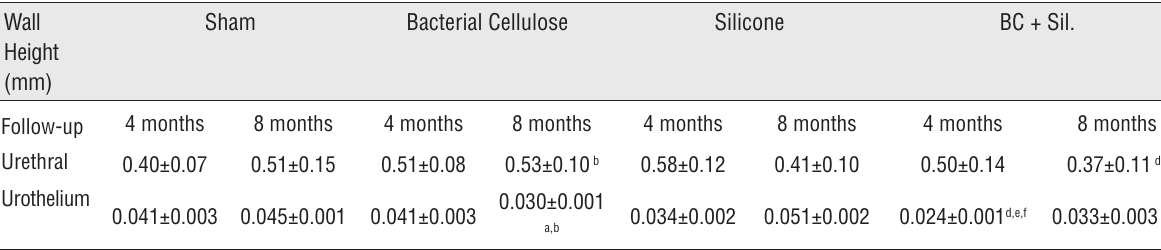
Table 1 - Urethral wall and Urothelium